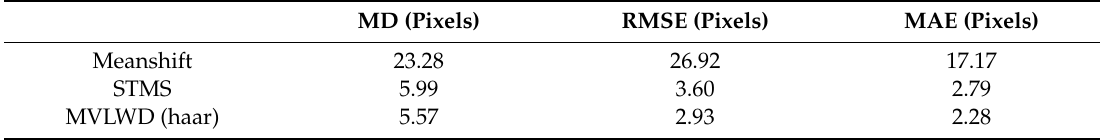
Table 4. Statistical performances for the three trackers on video